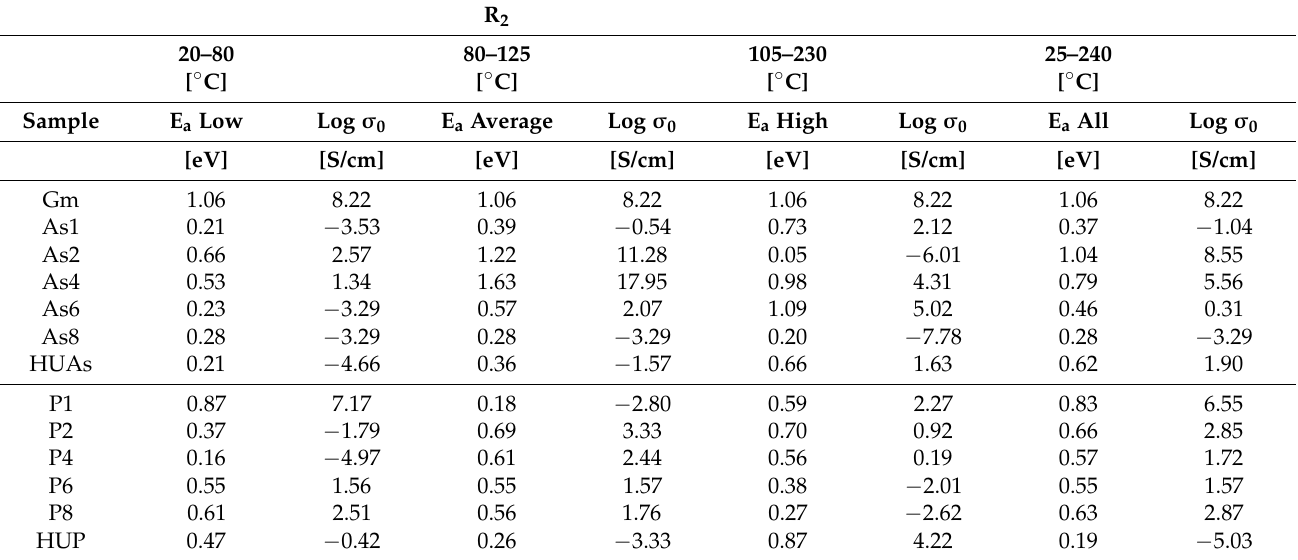
Table 4. Immittance investigations derived charge transport parameters for the systems studied for R 2